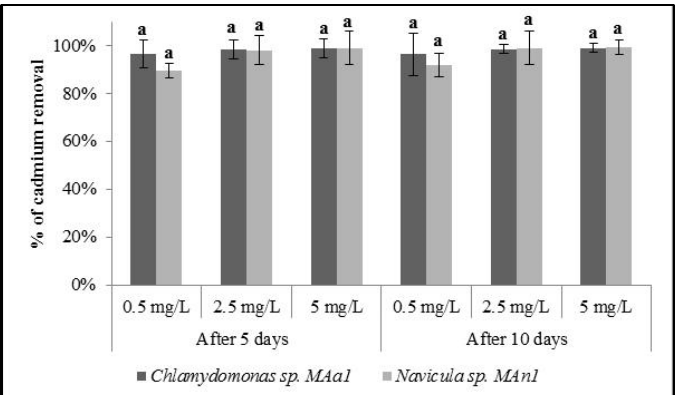
Figure 5. Capacities of Chlamydomonas sp. MA a1 and Navicula sp. MA n1 to remove cadmium from aqueous solutions. Data show means ± SD ( n = 3). Statistical significance was determined by one-way ANOVA followed by Duncan multiple range test; no significant difference ( p < 0.05) is indicated by the same lowercase